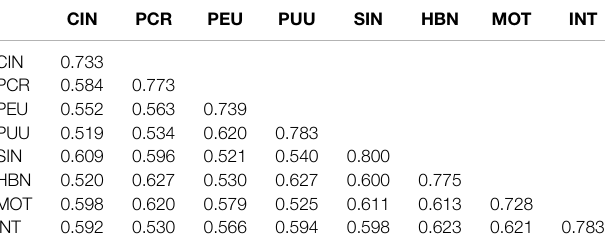
TABLE 7 | Predictive power of construct.